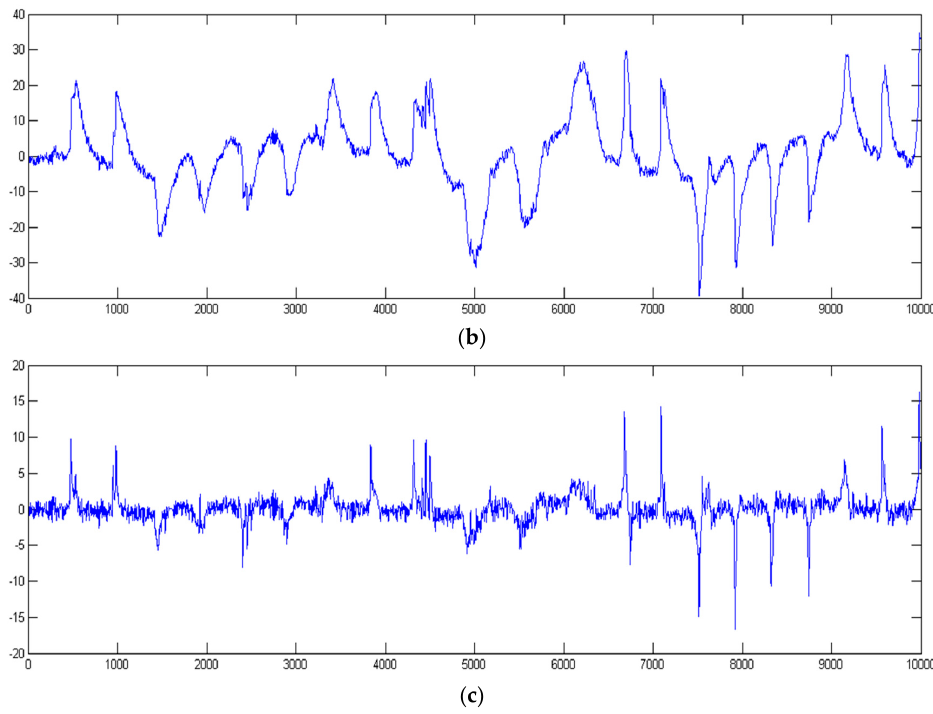
Figure 3. Effects of cut-off frequency of high pass filter on EOG signal. ( a ) filtered signal with 0.008 Hz cut-off frequency; ( b ) filtered signal with 0.1 Hz cut-off frequency; ( c ) filtered signal with 3.0 Hz cut-off frequency.